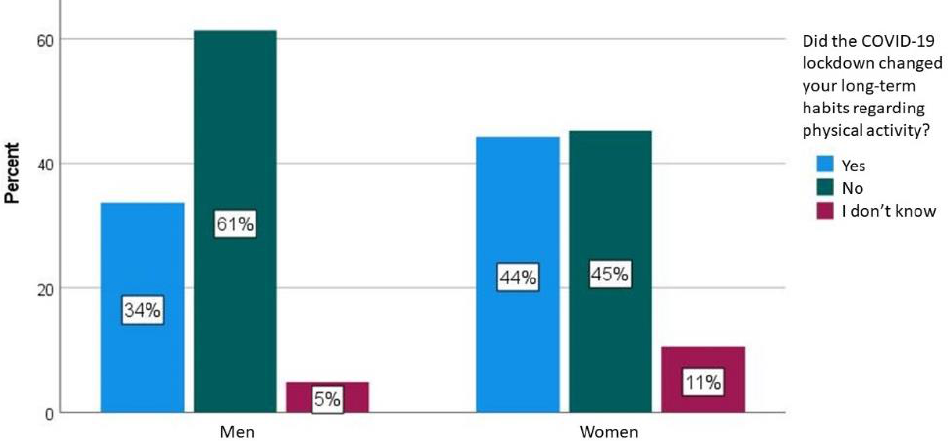
Figure 3. Long-term changes of physical habits due to the COVID-19 pandemic (N = 787). Note: Missing values are excluded from the calculation.